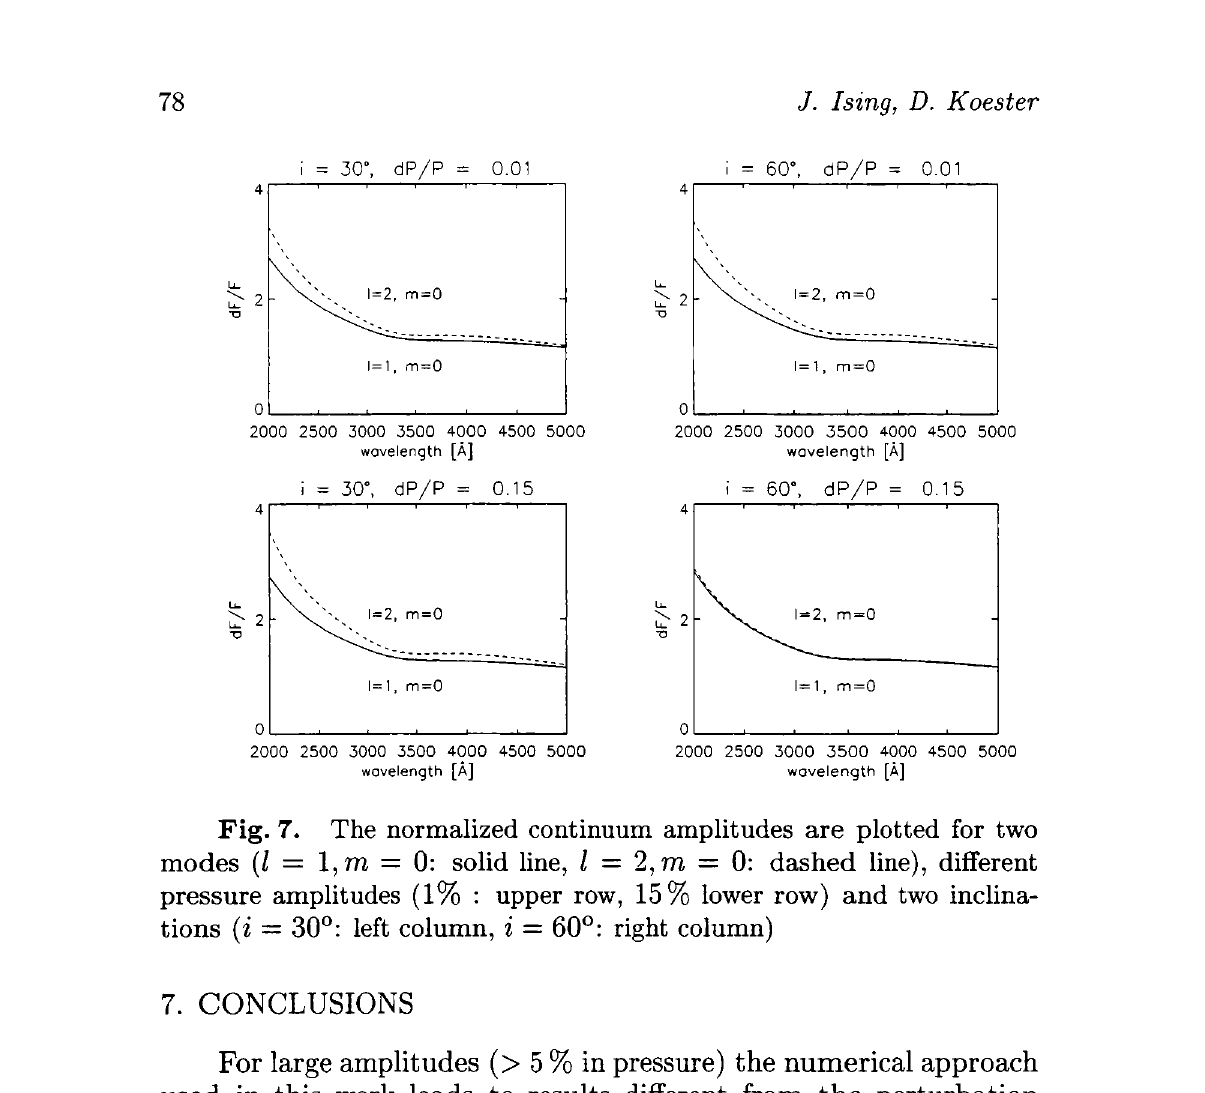
Fig. 7. The normalized continuum amplitudes are plotted for two modes (/ = l,m — 0: solid line, I = 2,m = 0: dashed line), different pressure amplitudes (1% : upper row, 15% lower row) and two inclina- tions (i = 30°: left column, i = 60°: right